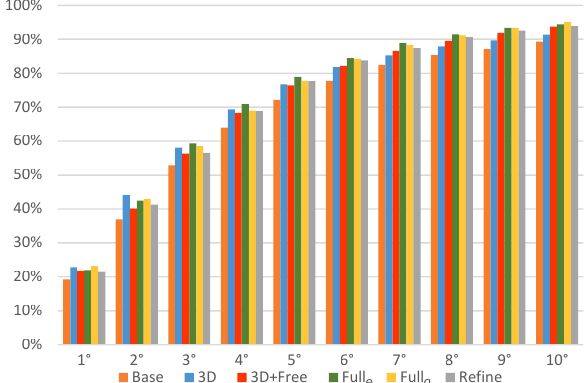
Figure 6. Cumulative histogram of absolute differences between estimated and reference orientation (correct orientation